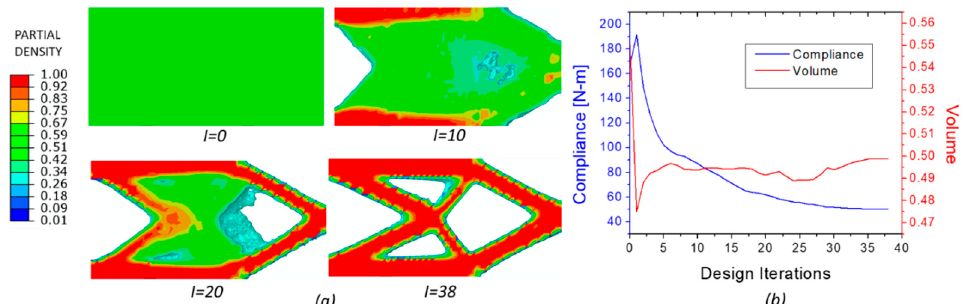
Figure 4. ( a ) Evolution of the design domain using topology optimization and ( b ) the history plot of the compliance and volume for the optimization process.